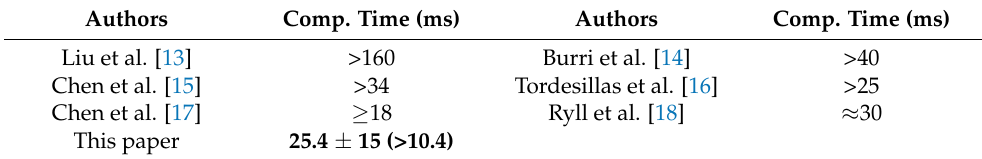
Table 4. Comparison with state-of-the-art algorithms on computing time of the collision-avoidance maneuver. In the Table, the bold number means the best performance of the computing time. The data used to calculate the computing time of the proposed maneuver are obtained from the experiments of Table 3.